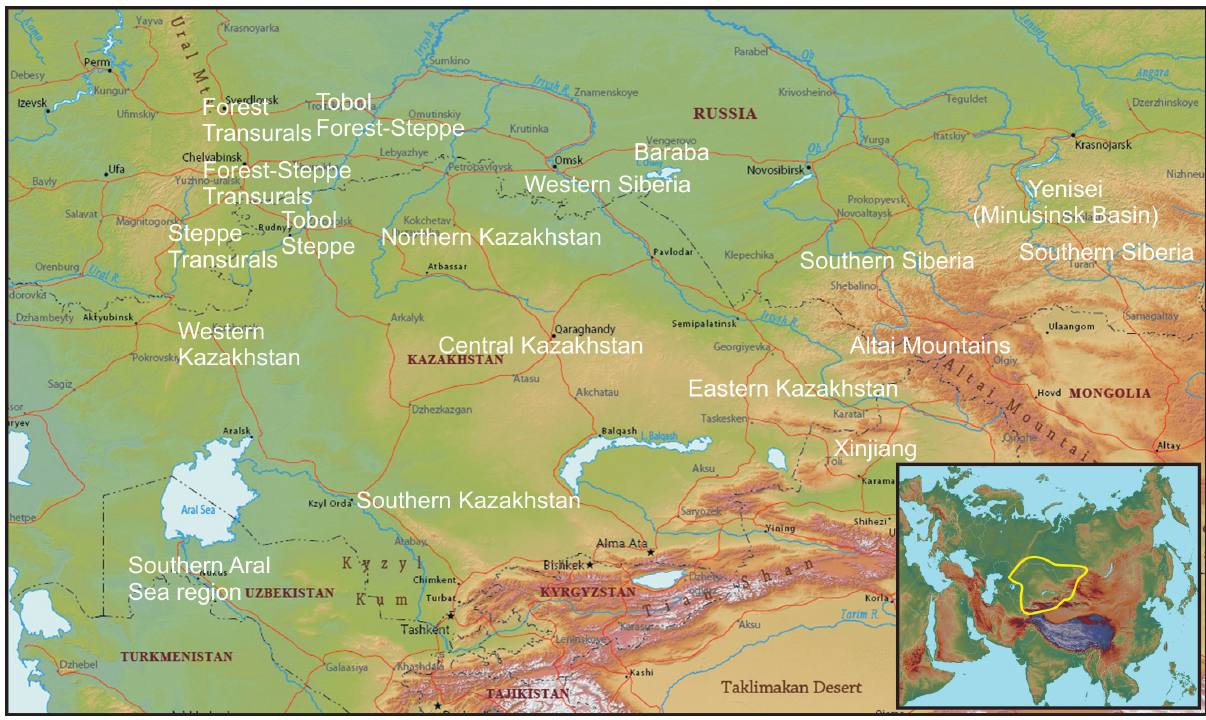
Figure 1: The distribution area of the Andronovo sites on the map of Eurasia and geographical areas mentioned in the